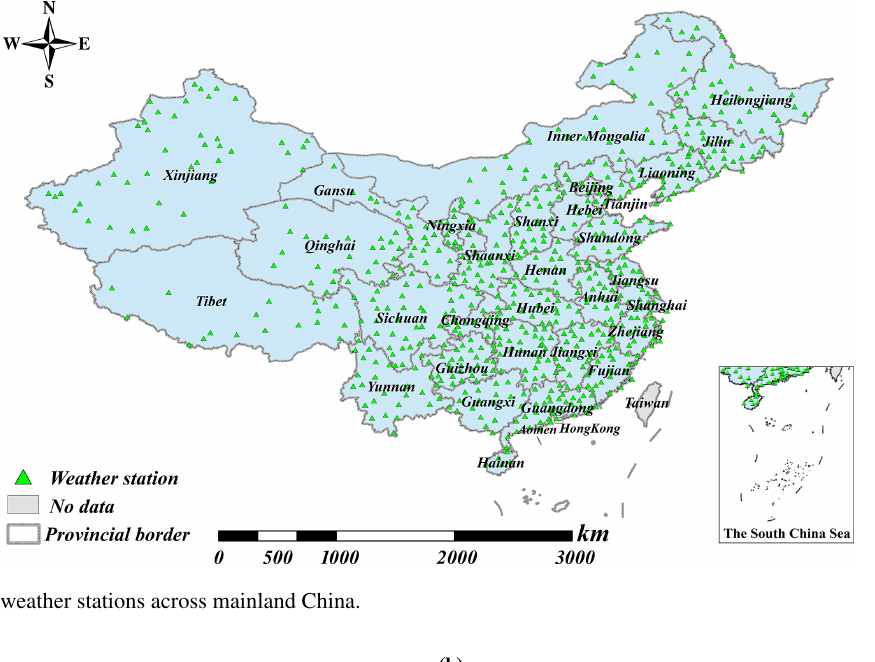
Figure 1. Considered weather stations across mainland China.